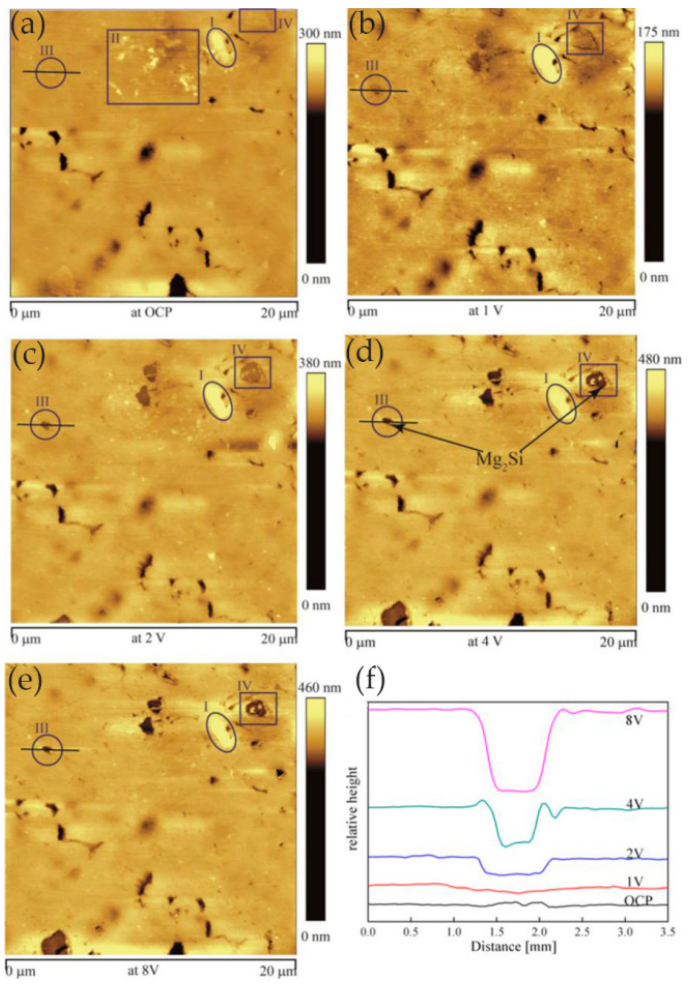
Figure 19. In situ EC-AFM topography images of the Al 6060 alloy in 0.2 M Na 2 SO 4 solution at ( a ) OCP, ( b ) 1 V, ( c ) 2 V, ( d ) 4 V, and ( e ) 8 V vs. Ag/AgCl. ( f ) Line profiles across the feature III in ( a – d ). Adapted with permission from Reference [54]; copyright 2016 Electrochemical Society.